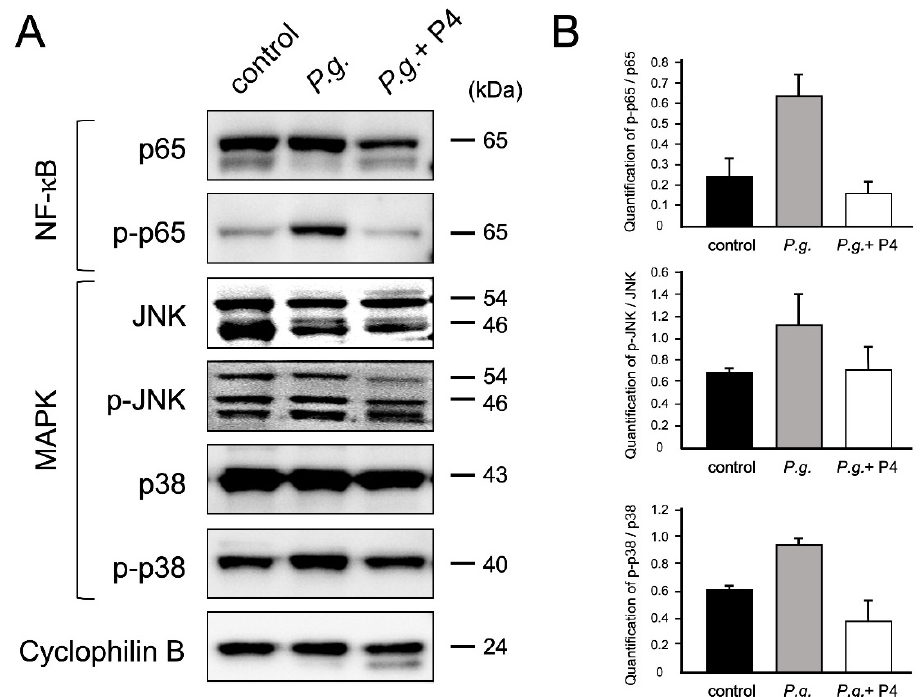
Figure 2. P4 inhibited P.g .-induced NF-kB and MAPK phosphorylation ( A ) Western blot analysis was performed to detect the phosphorylation levels of NF- κ B and MAPK signaling. Lane 1: control mice; Lane 2: P.g . mice; Lane 3: P.g. + P4 mice. ( B ) Densitometric data of protein analysis. The phosphorylated/total protein ratio was then quantified. Total and phosphorylated proteins were normalized to cyclophilin B in each group (control, P.g., and P.g. + P4). Experiments were performed using three independent tissue samples. Values represent the mean ± SD (n = 3).